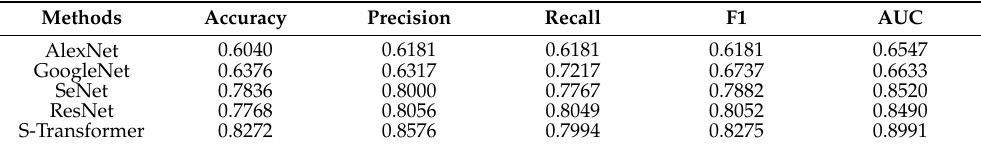
Table 1. Performance comparison between the swin transformer and the typical CNN baselines. We follow the authors’ instructions on implementing CNN methods, and report their best